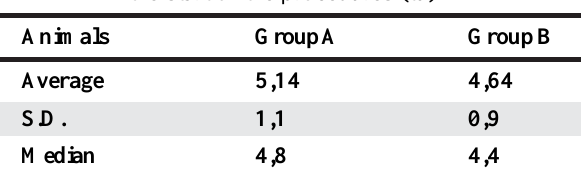
TABLE 1 - Standard deviation average and median of the diameter measures (mm) of the radiologic image of choledoc duct in the animals of group A (with papilla dilation) and group B (sham), in the start of the procedures (t0)